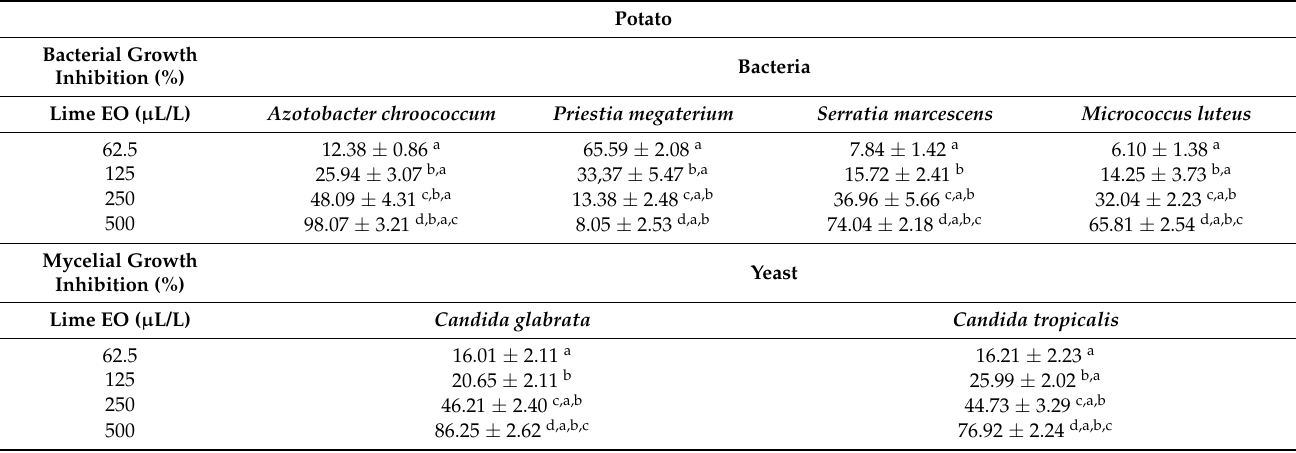
Table 5. In situ analysis of the antibacterial activity of the vapor phase of CAEO in potato.